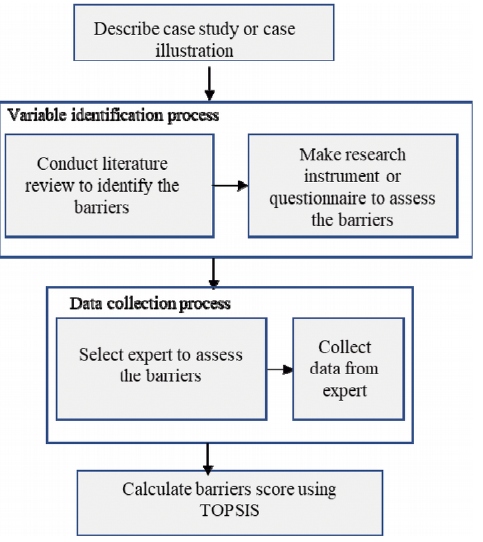
Figure 4. Research Methods